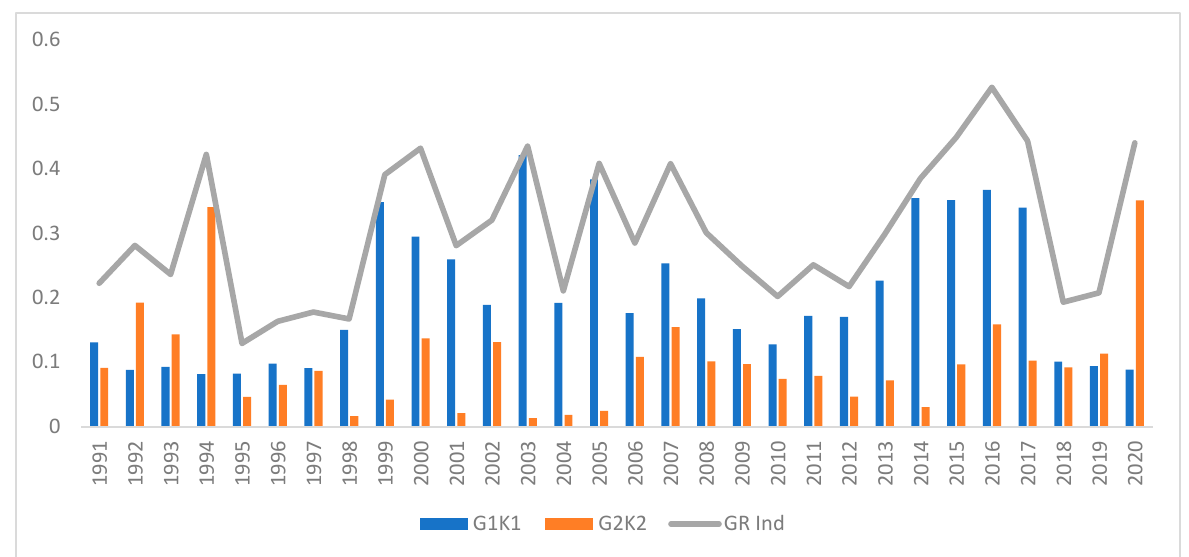
Figure 7. Governance and regulation index and sub-indices.